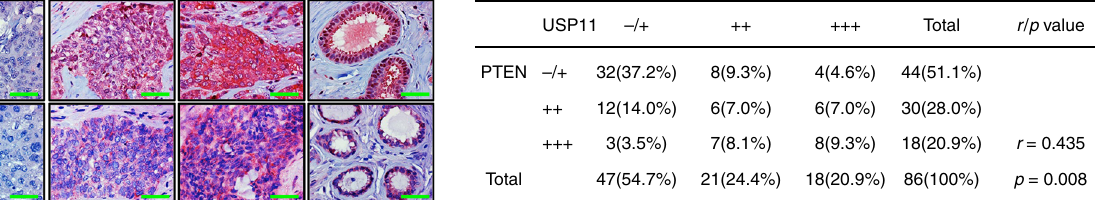
Fig. 5 USP11 is downregulated and correlates with PTEN in human cancers. a, b USP11 expression in human prostate ( a ) and breast ( b ) cancers using a previously published microarray database. Stephenson ’ s CaP, prostate carcinoma (ref. 44 , n = 97); Taylor ’ s CaP (GEO: GSE21032, n = 179); Liu ’ s BCa, breast carcinoma (GEO: GSE22820, n = 176). The line in the middle, upper end, and lower end of the boxplot represents the mean, upper, and lower quartile of the relative mRNA level of all samples, respectively. The lines above and below the box are the maximum and minimum values. Data points beyond the whiskers ( > 1.5 interquartile ranges) are drawn as individual dots. Error bars represent ± SEM. p Value was determined by Student ’ s t test (** p < 0.01; *** p < 0.001). c Online analysis of relapse-free survival (RFS) ( n = 618) and overall survival (OS) ( n = 241) in human basal-type breast cancer patients with high or low USP11 expression. The number of surviving patients at different time points is indicated below the graphs. p Value was determined by log-rank (Mantel – Cox) test. HR, hazard ratio. d Fluorescence in situ hybridization (FISH) analysis of PTEN in human prostate (left, n = 116) and TNBC (right, n = 103) tumor samples. The table indicates the frequency of PTEN immunohistochemical (IHC) status by PTEN FISH status. Correlation between PTEN IHC and PTEN FISH was determined by the PASS Pearson Chi-square test. e IHC analysis of USP11 and PTEN in human prostate (top, n = 99) and TNBC (bottom, n = 86) tumor samples (left). Scale bars, 50 μ m. Correlation between USP11 and PTEN protein levels was determined by the PASS Pearson Chi-square test (right). r , correlation coef fi cient. TNBC, triple-negative breast cancer